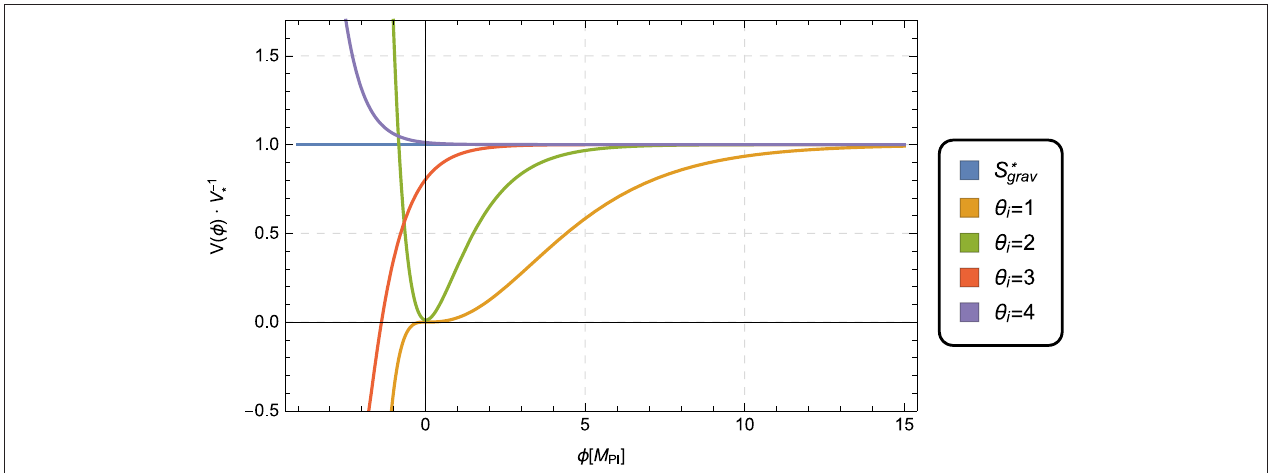
θ 2 [91]. The = V ( φ ) V * M Pl . The scalar field φ thus acquires δ V ( φ ), such that V ′ ( φ ) 0 at φ → = + 6= ∼ θ 2 2 = =